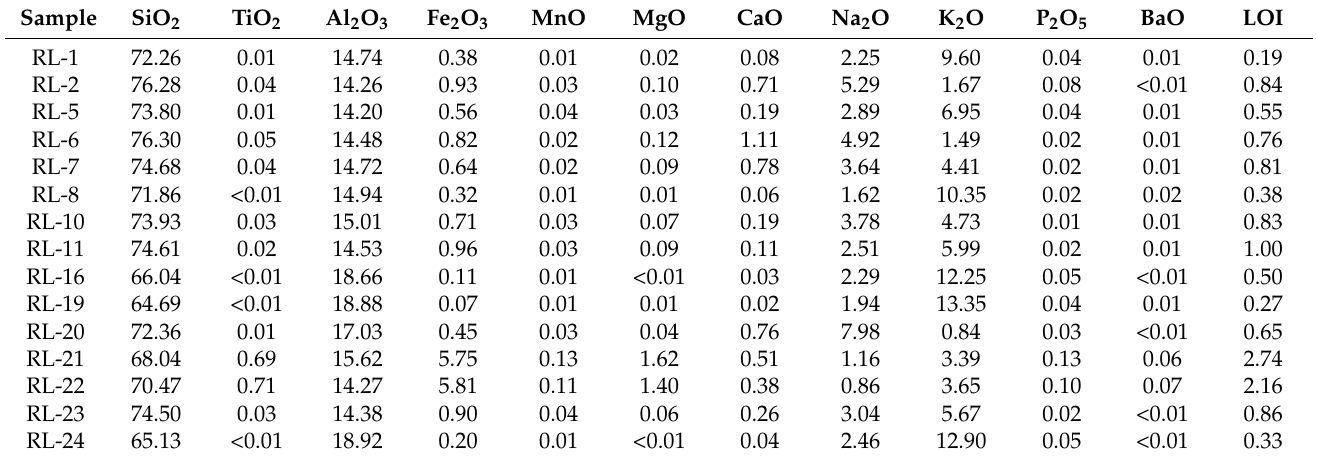
Figure 5. The ( A ) micrograph and ( B ) backscattered electron (BSE) images of apatite from RL-6, RL-10, and RL-16. Table 1. Major elements composition of the pegmatite from Renli Nb-Ta deposit (wt.%).